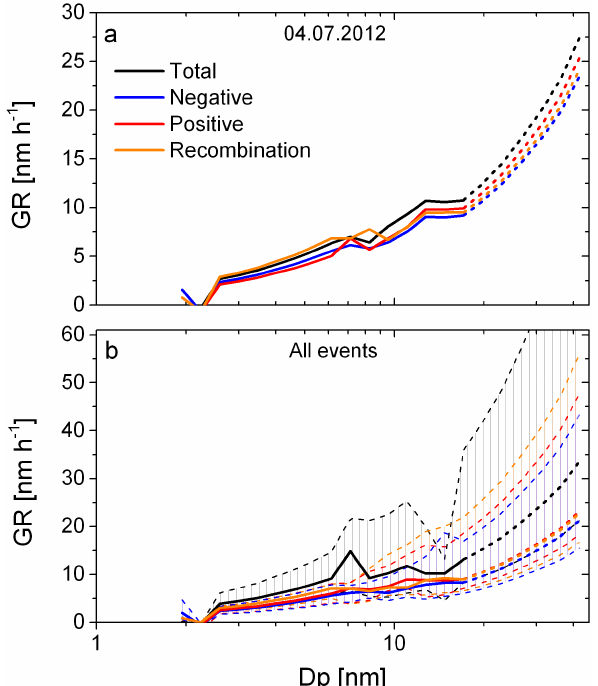
Figure 6. Growth rates of negative ions, positive ions and total par- ticles determined from NAIS measurements, (a) for a single event on 4 July 2012 and (b) median values for all 8 selected NPF events used for this study. Hatched areas denote the 25th and 75th per- centile. Additionally, GR rec deduced from ion–ion recombination is shown in orange. Dashed segments of the curves denote inaccu- rate growth